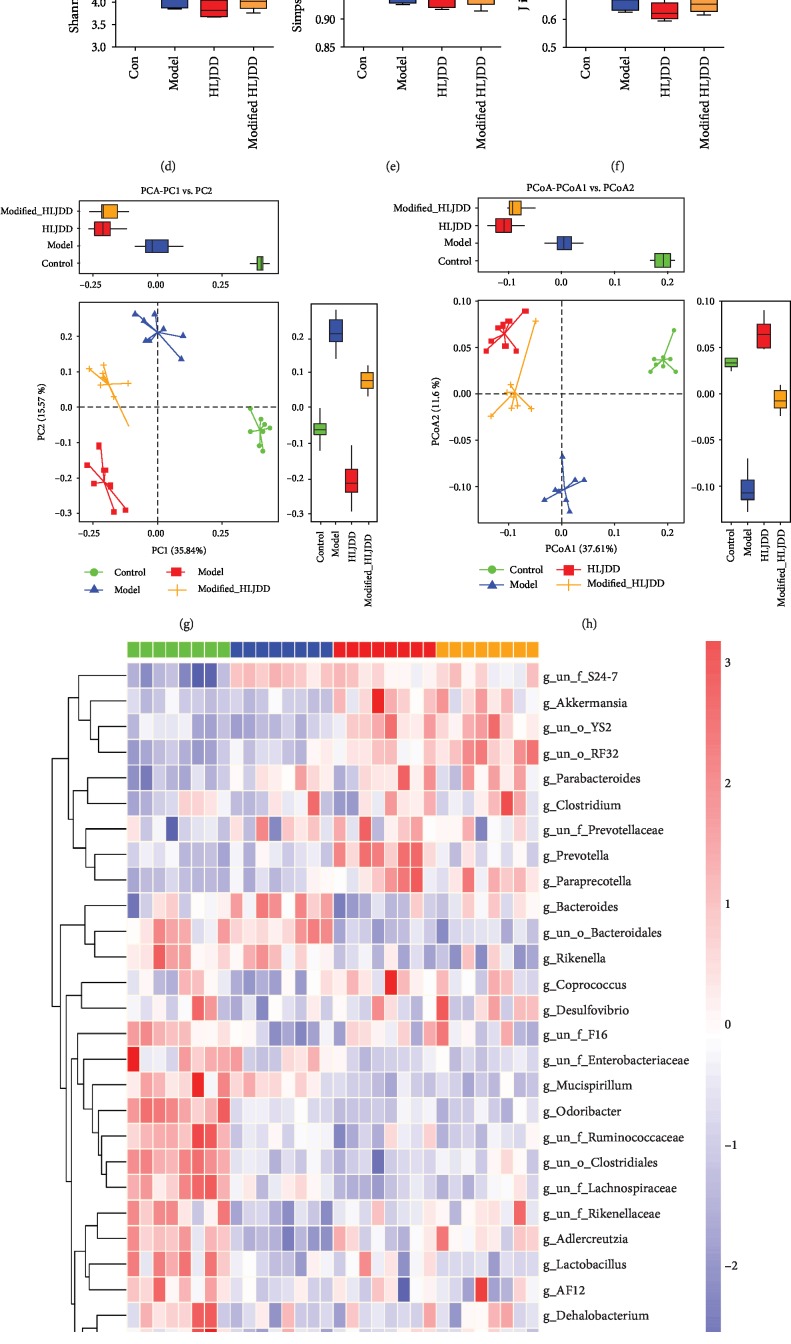
Effect of HLJDD and modified-HLJDD treatments on gut microbiota in an AD model. Six α-diversity of gut microbiota, including (a) observed species (OTUs), (b) Chao1, (c) ACE, (d) Shannon, (e) Simpson, and (f) J diversity indices, are shown. β-Diversity is shown in the fashion of (g) PCA plots and (h) PCoA plots. (i) The hierarchy cluster heatmap revealing the top 30 most abundant differentiated taxa at the genus level in feces samples. n = 8 per group. Results are expressed as the mean ± SEM. ∗∗p < 0.01, ∗p < 0.05 vs. control group. Statistical significance was determined by one-way ANOVA and Bonferroni tests as post hoc comparisons.